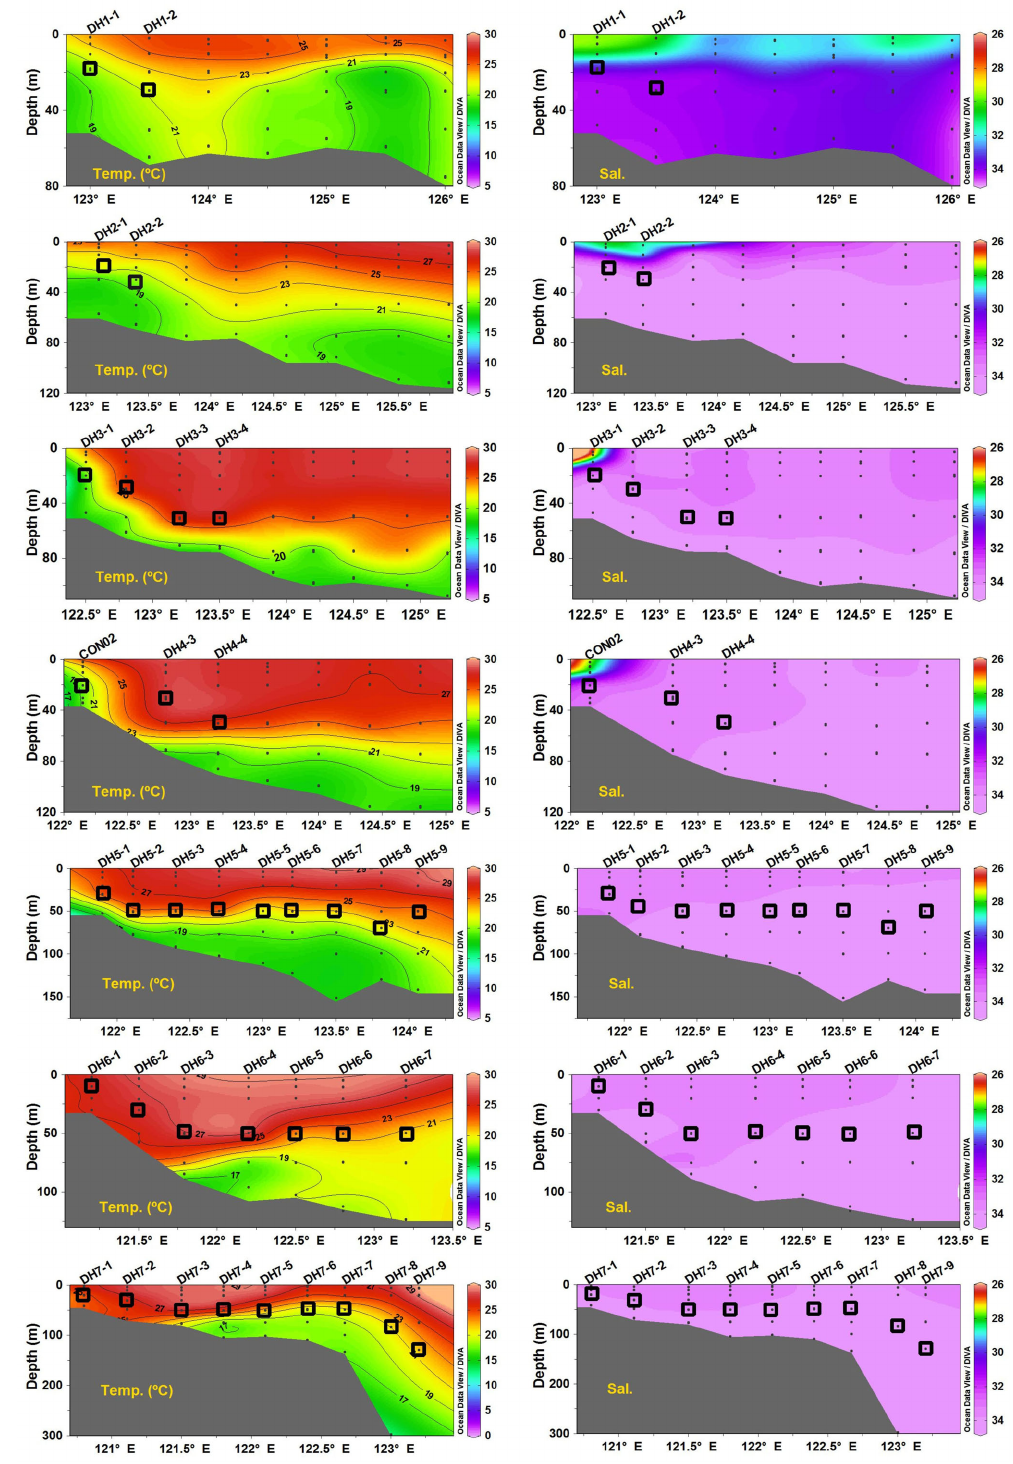
Figure 2. Vertical distributions of temperature and salinity along seven transects across the southern East China Sea during summer 2013. Note that there is an obvious thermally stratified water column during the collection of suspended particles in the study